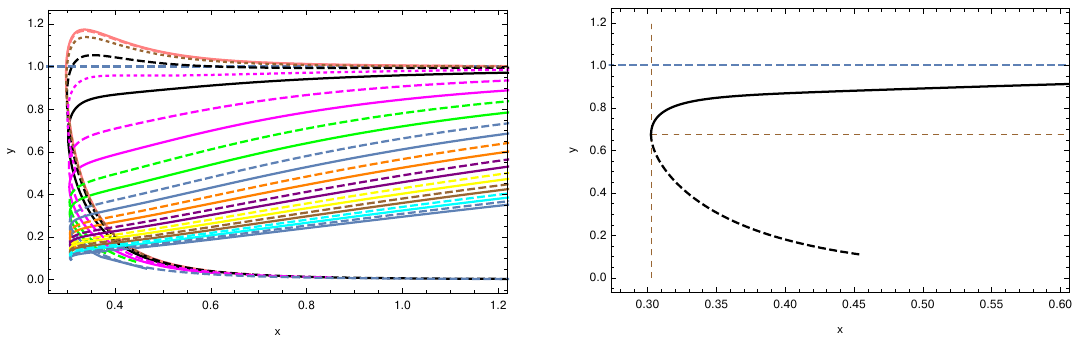
Figure 5 . Left panel: entropy densities s in n CFT m models, relative to the entropy density of the UV (cid:12)xed point (the N = 4 SYM in this case) s UV at the corresponding temperature (see (1.8)), as p functions of T= B . Color coding of the solid curves agrees with that in (cid:12)gure 4 | see (1.10) for the set of the hypermultiplet masses. Additional dashed and dotted curves correspond to additional values of m , within the same interval (1.10). Each n CFT m model has a terminal critical point. p In the right panel we show this for the model with m= 2 B = 1: the brown lines identify the p critical temperature T crit = B and the relative entropy at the criticality s crit =s UV (these quantities are presented in (cid:12)gure 7). \Top" solid black curve denotes the thermodynamically stable branch and \bottom" dashed black curve denotes the thermodynamically unstable branch (see (cid:12)gure 6 for further